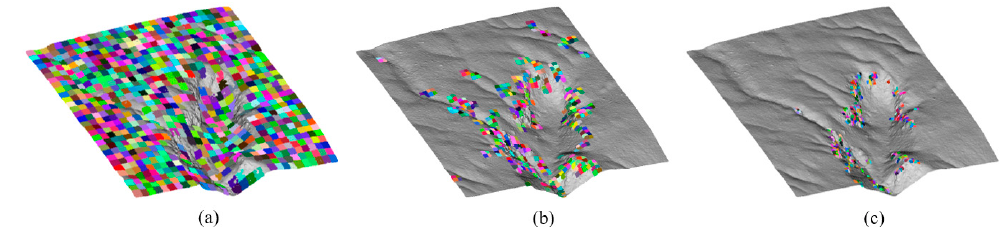
Figure 7. The results of progressive RANSAC plane detection in the sample site. ( a ) Gentle slopes, ( b ) steep slopes, and ( c ) discontinuous terrain are represented by large-, medium-, and small-scale planes, respectively. Colored square and gray surface indicate detected planes and true terrain, respectively.